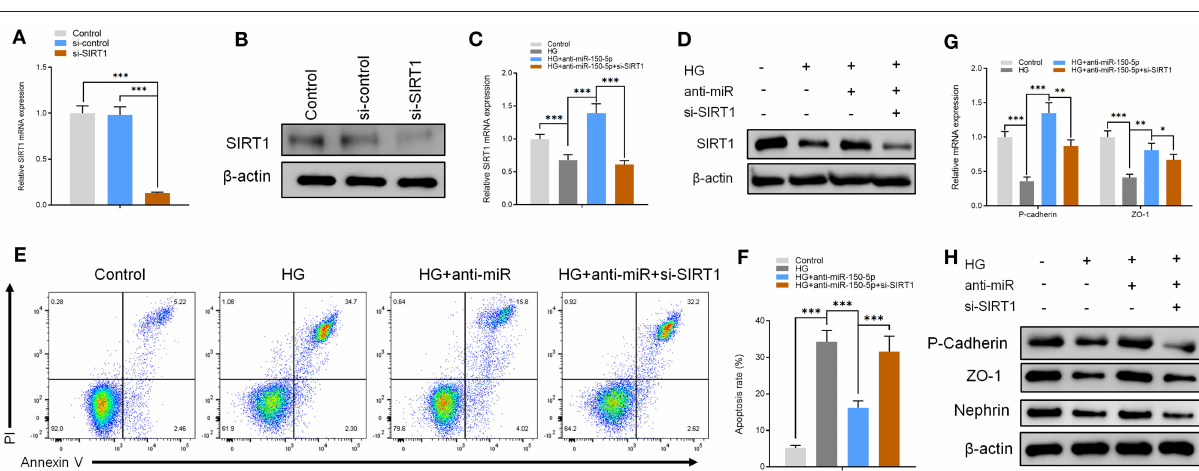
p62, suggesting that anti-miR-150-5p promotes autophagy